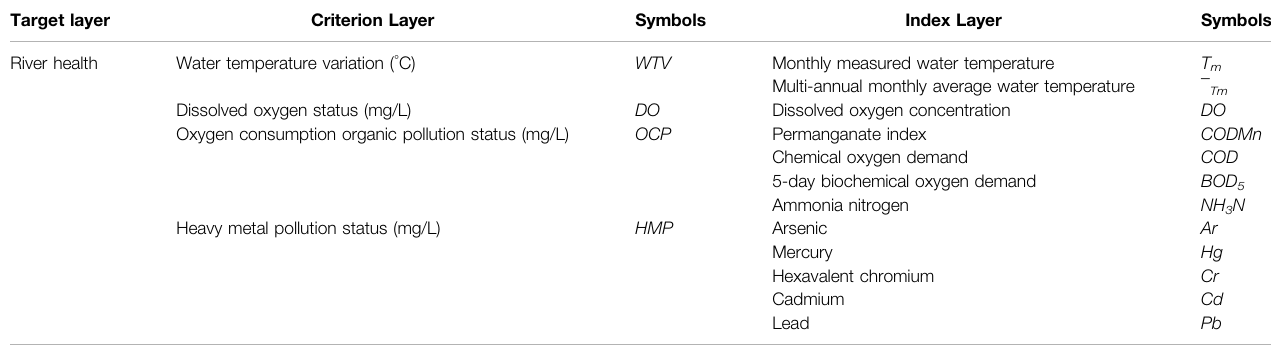
The italic value is the abbreviation.